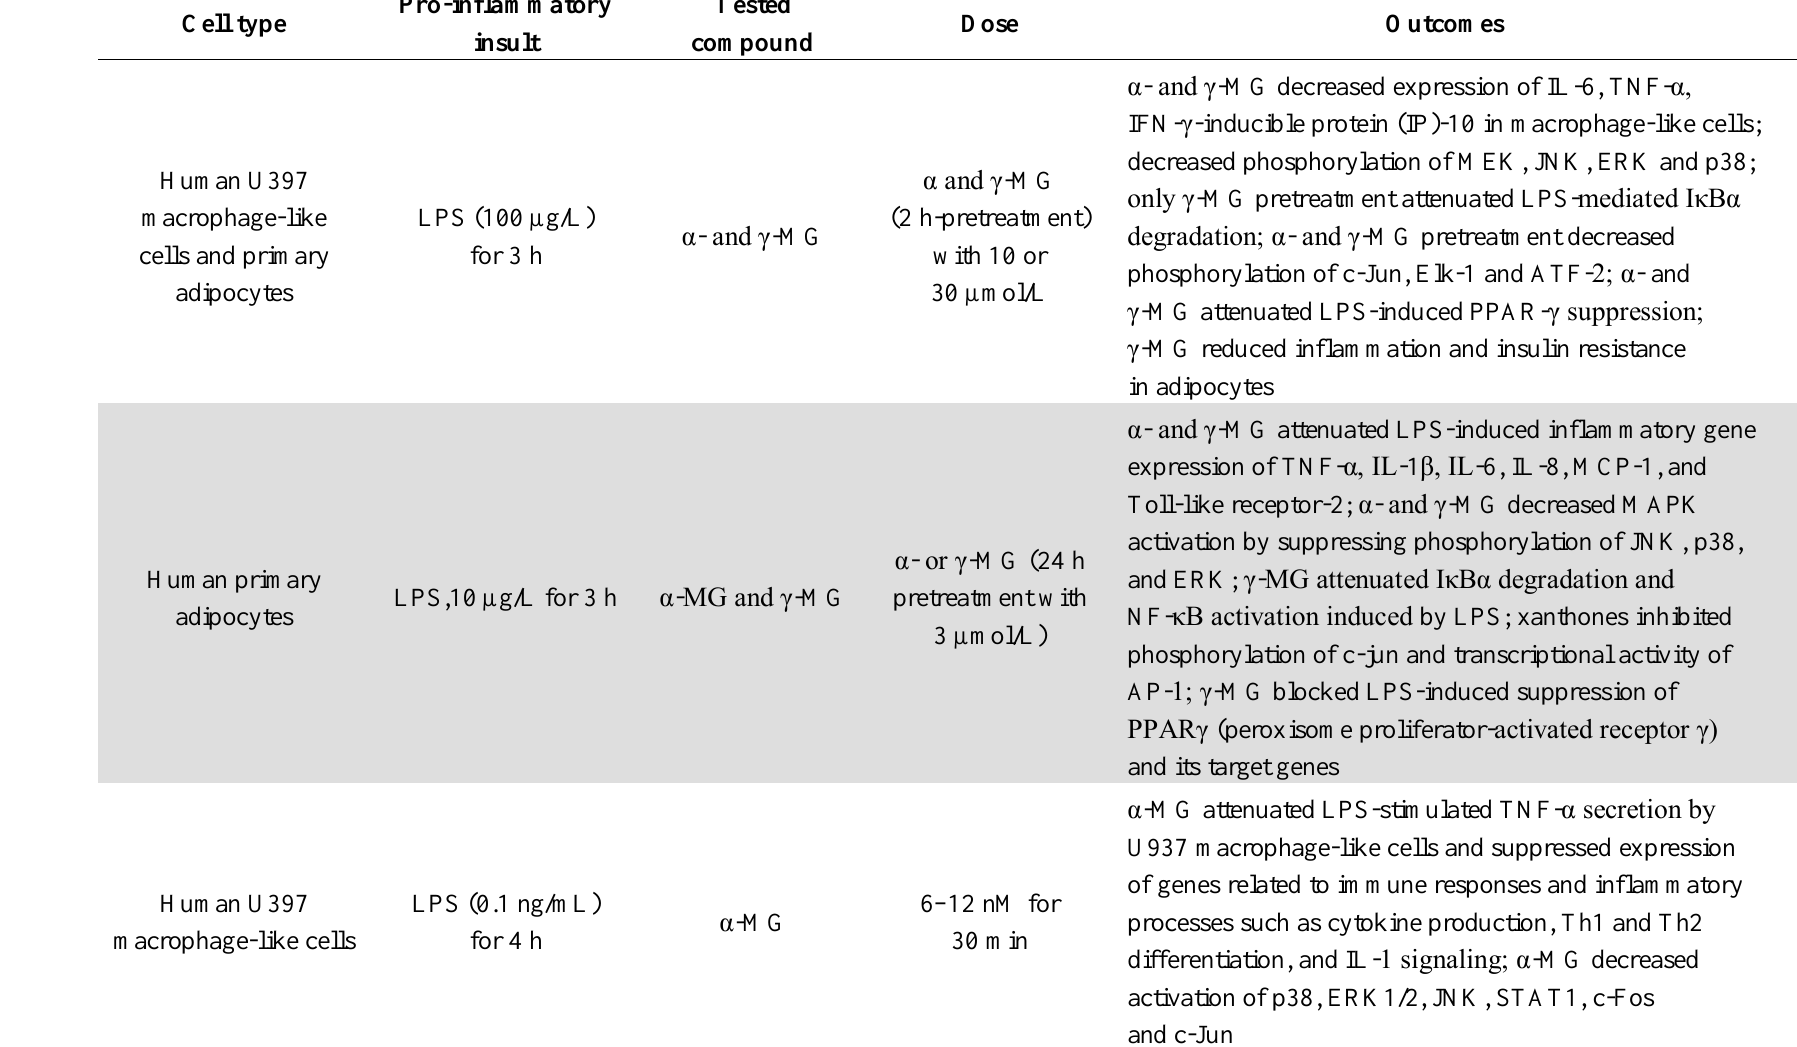
Table 4. In vitro anti-inflammatory activities of mangosteen